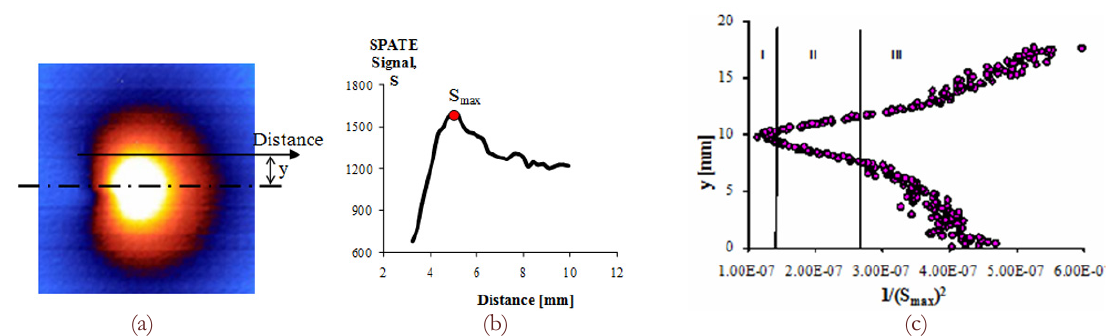
Figure 2: A typical set of data points from a thermoelastic scan of a crack (Stanley and Chan